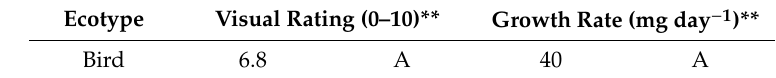
Table A2. Visual rating (0–10) and growth rate (mg day − 1 ) of each Vallisneria americana ecotype is compared under increased salinity condition. The control (0.2 ppt) treatment is excluded from this analysis. Plants were assigned a visual quality score on a numerical scale of 0 through 10, where 0